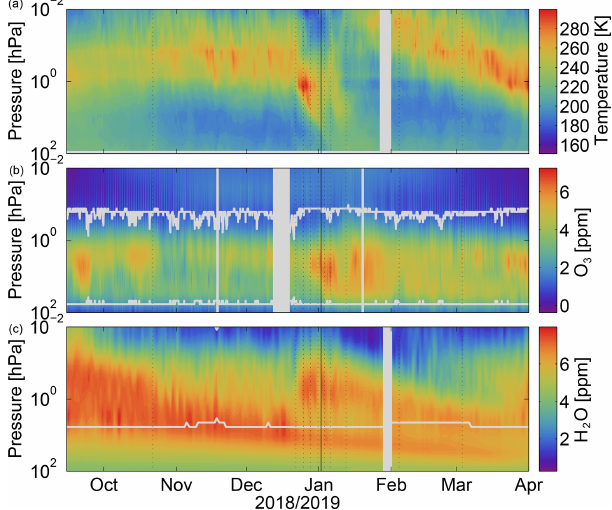
Figure 7. EOS-MLS temperature (a) , GROMOS-C ozone VMR (b) and MIAWARA-C water vapour VMR (c) time series at Ny- Ålesund for winter 2018/2019. The dotted lines indicate the dates of the polar vortex snapshots in Fig. 6 and the solid line shows the central date of the SSW. The grey background indicates data gaps and the grey lines indicate the upper and lower bounds of the area where the measurement response is larger than 0.8 for GROMOS-C and the lower bound of this area for